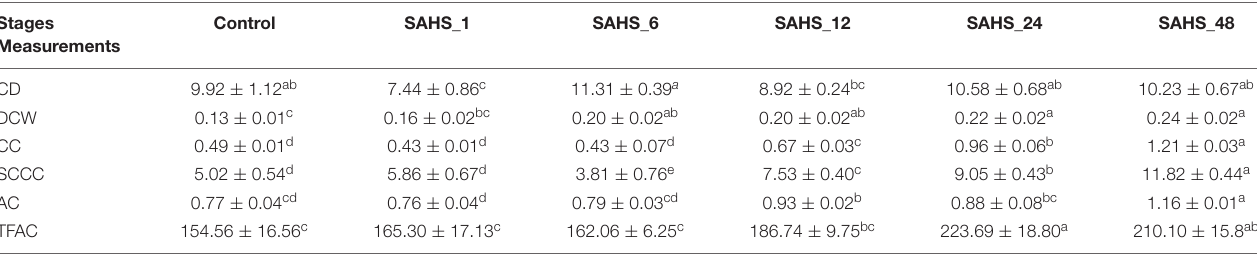
FIGURE 1 | Microscopic images of Haematococcus pluvialis cells at different SAHS treatment stages. (A–F) represent the samples of Control, SAHS_1, SAHS_6, SAHS_12, SAHS_24, and SAHS_48, respectively. Scale bar = 20 µ m. TABLE 1 | Effects of SAHS treatments on growth measurements of Haematococcus